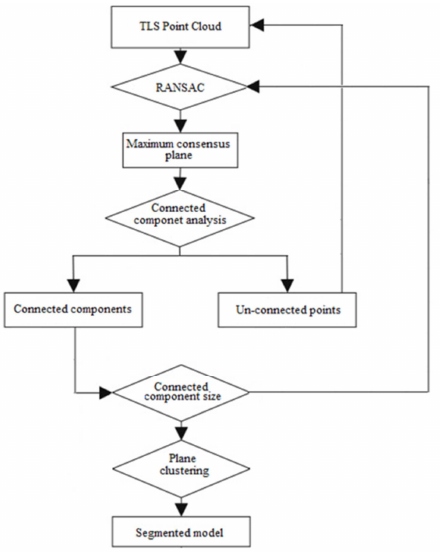
Figure 3. Workflow of developed segmentation